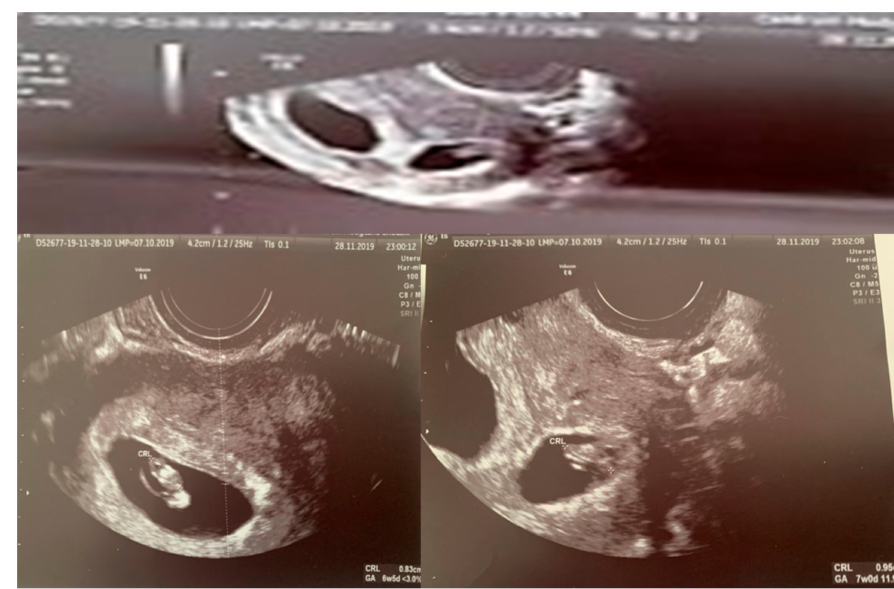
Figure 2. USG scan of twin pregnancy (dichorionic diamniotic—7 week of pregnancy) in patient with Swyer syndrome.